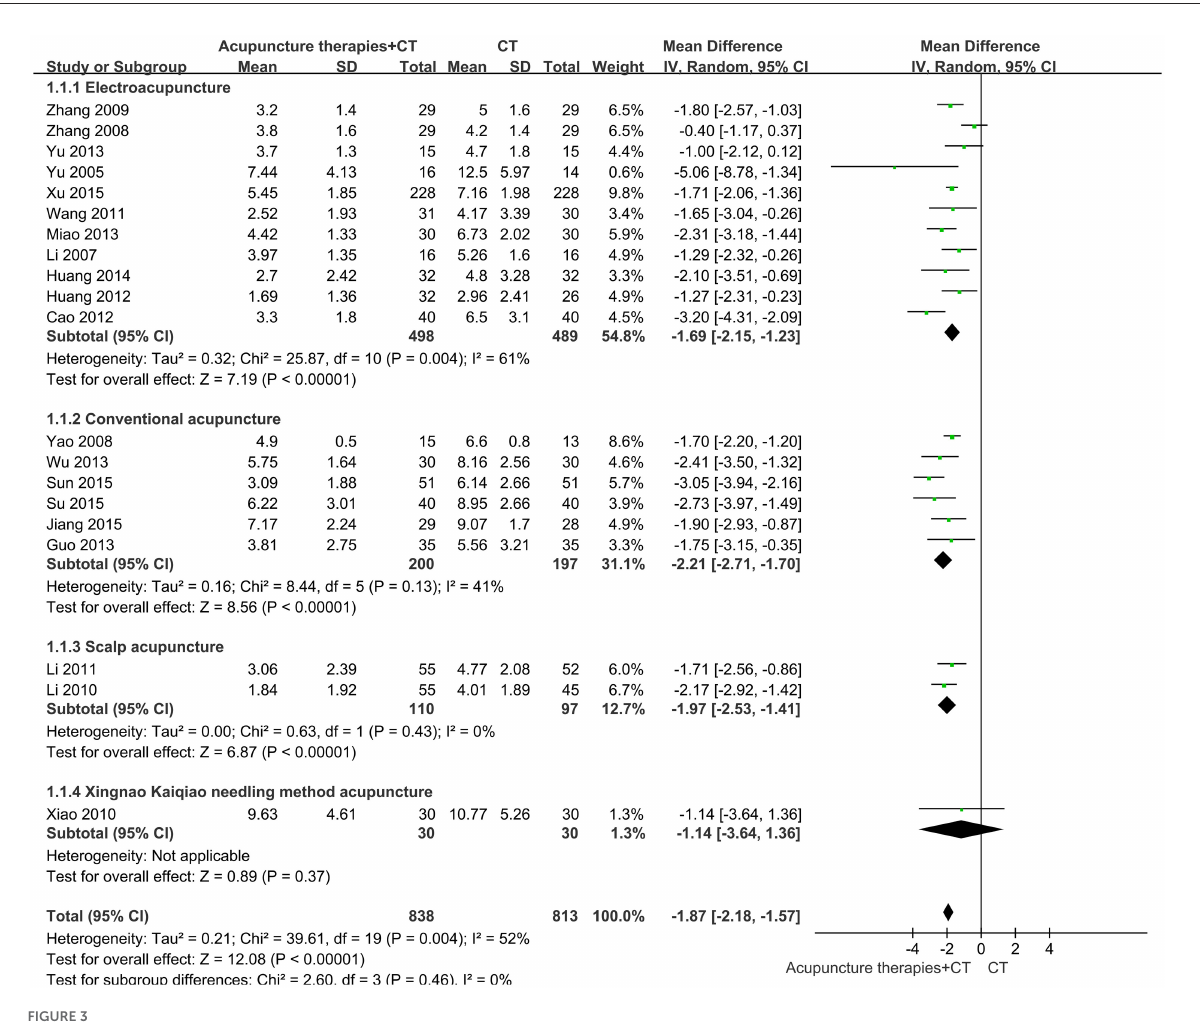
FIGURE3 Subgroup analysis of the NIHSS in patients receiving acupuncture therapies within 1 month after AIS